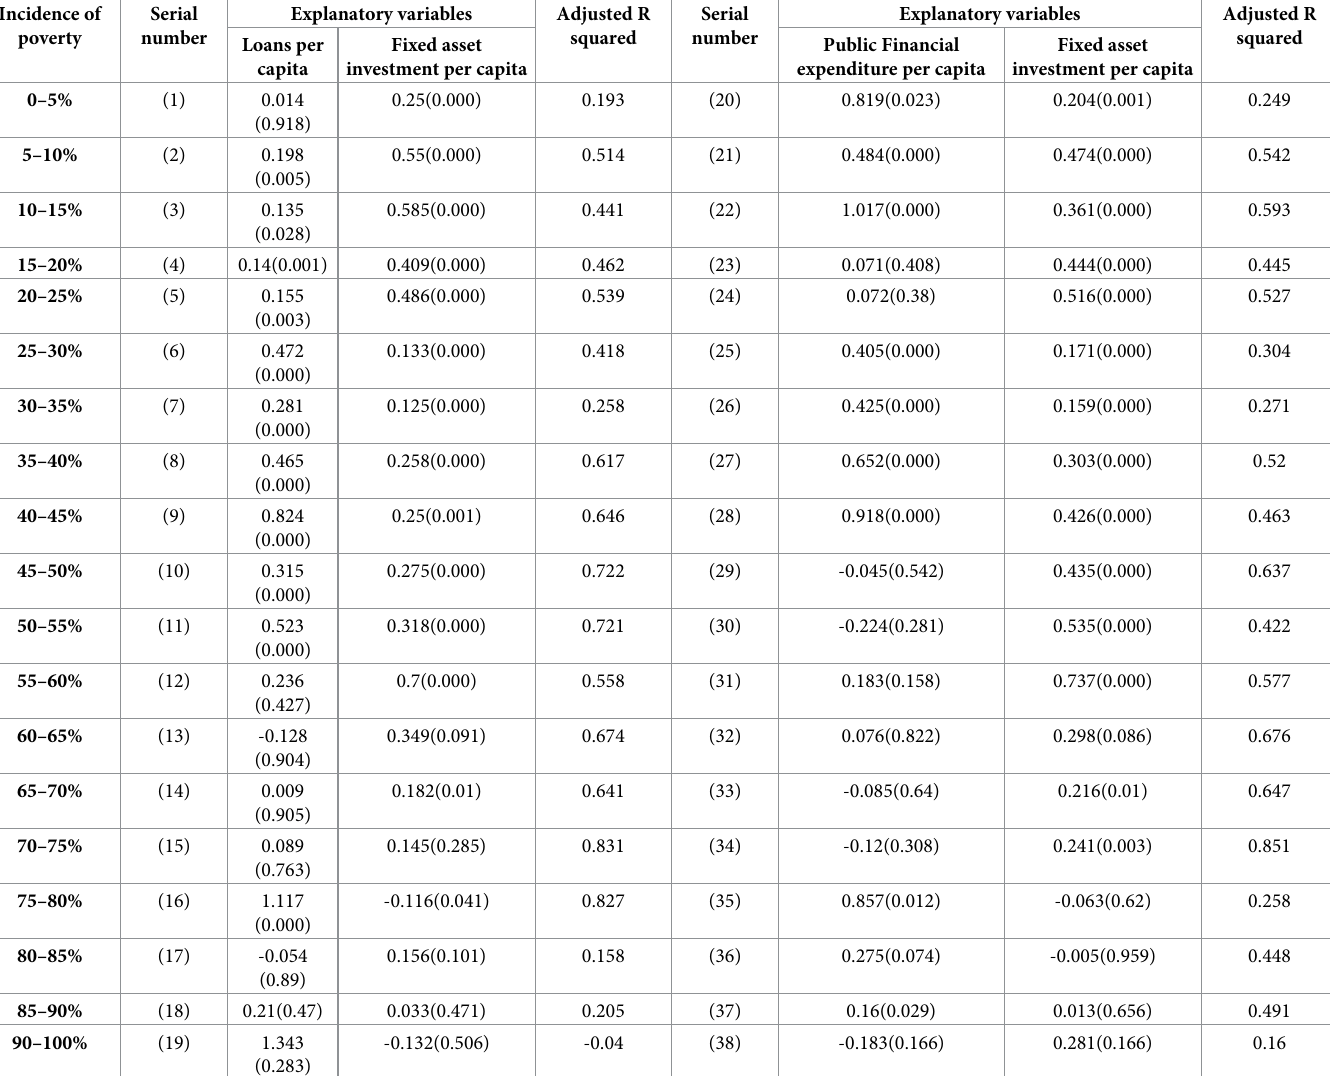
Table 4. Linear relationship between per capita GDP (dependent variable) and the explanatory variables under different poverty incidence. Incidence of